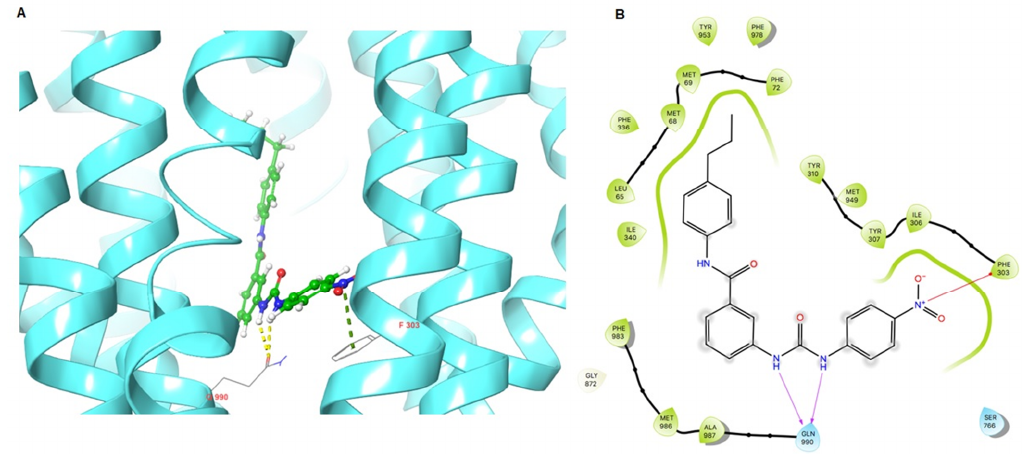
Figure 9. Molecular interaction of VKNG-2 with the human ABCB1 model. ( A ) Docking pose of VKNG-2 within the binding pocket of ABCB1. The protein is represented as sky blue colored ribbons. Amino acid residues are represented as follows: carbon in gray, hydrogen in white, nitrogen in blue and oxygen in red. The ligand is represented by the ball and stick model with carbon atoms represented in green, oxygen in red nitrogen in blue and hydrogen in white. Green dashes represent π -cation interactions and yellow dashes represent hydrogen bonding. ( B ) 2-D ligand interaction between VKNG-2 and ABCB1. Red arrows indicate π -cation interaction with amino acid residues within 5 Å of the ligand and the magenta arrows represent hydrogen bonding.